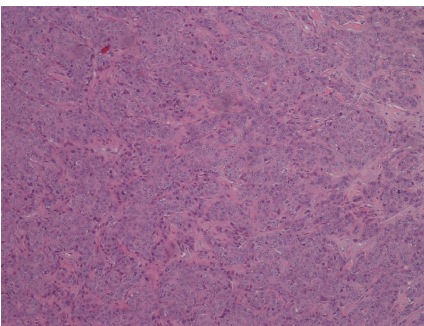
Figure 1: Eccrine carcinoma. Infiltrative, poorly differentiated neoplasm in a nested to trabecular pattern. Nuclei are relatively uniform with notably prominent nucleoli (hematoxylin-eosin, original magnification × 200).